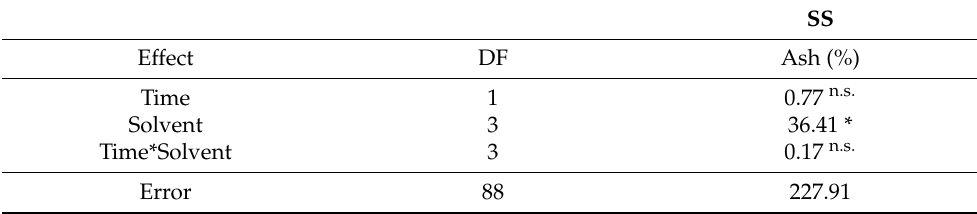
Table 3. Results of univariant analysis of ash content.